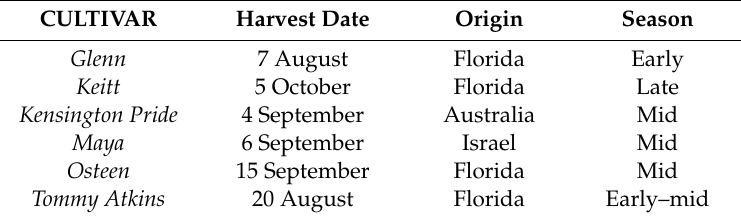
Table 1. Harvest date of the six mango cultivars in